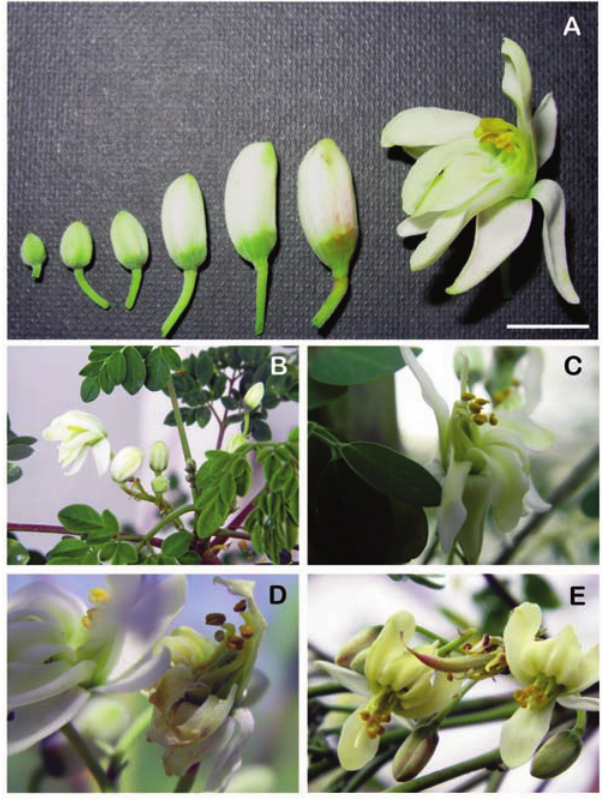
Fig. 3 - Pistil of Moringa oleifera Lam. A, external view of the pistil; B, internal view of the ovary with ovules; C, detail of the stigma. Bars = A-C,